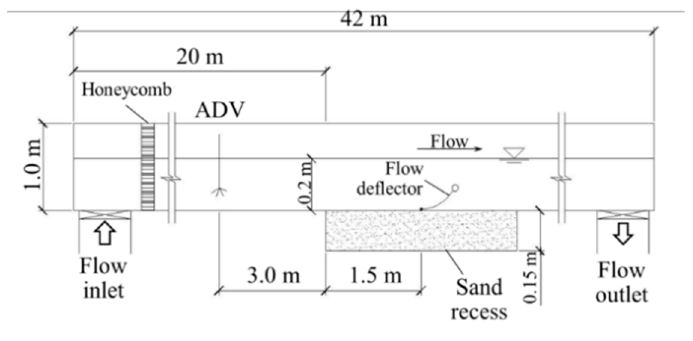
Figure 2. Side view of the experimental water flume (not to scale).